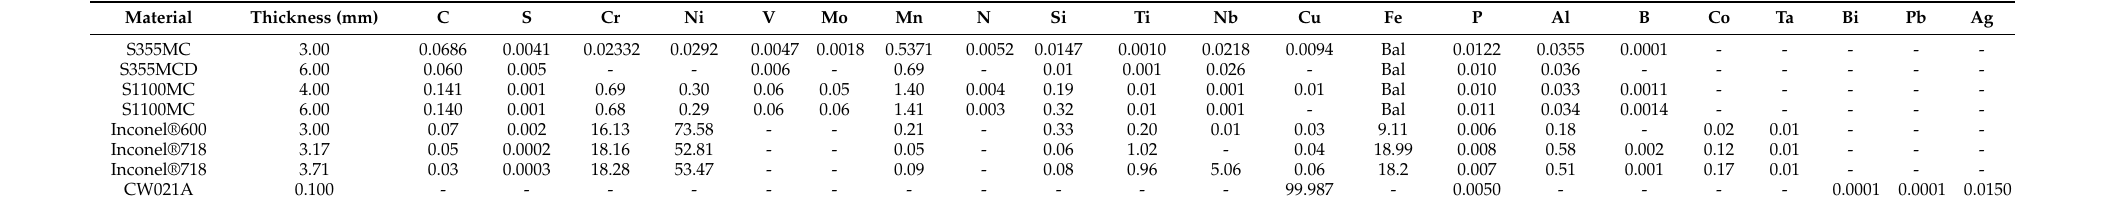
Table A1. Chemical composition (weight %) of the parent materials based on material certificates.